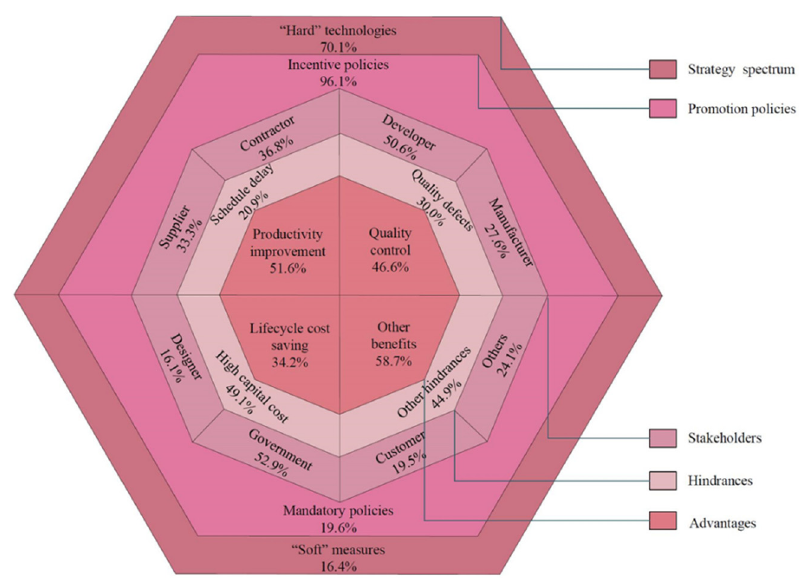
Figure 2. Prefabrication implementation research framework.